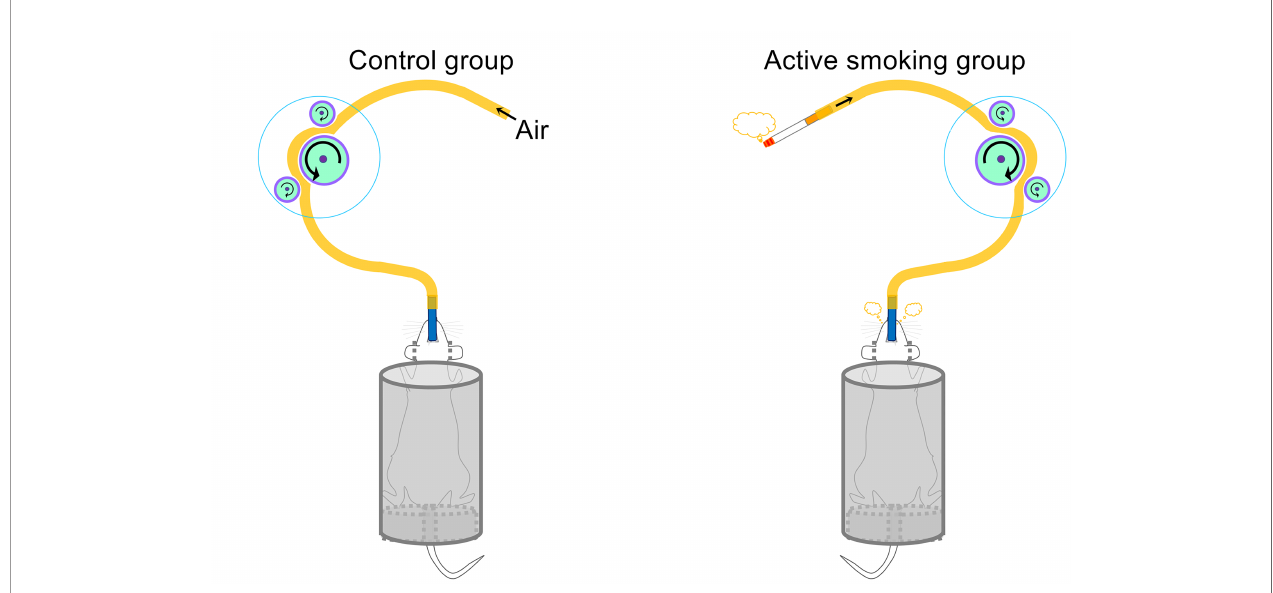
FIGURE 1 | Schematic of the control and active smoking